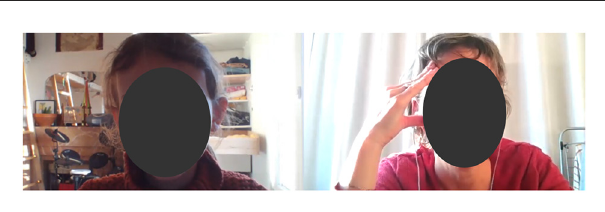
FIGURE1 A snapshot of one of the recording sessions involving a child and her caregiver communicating through an online video chat